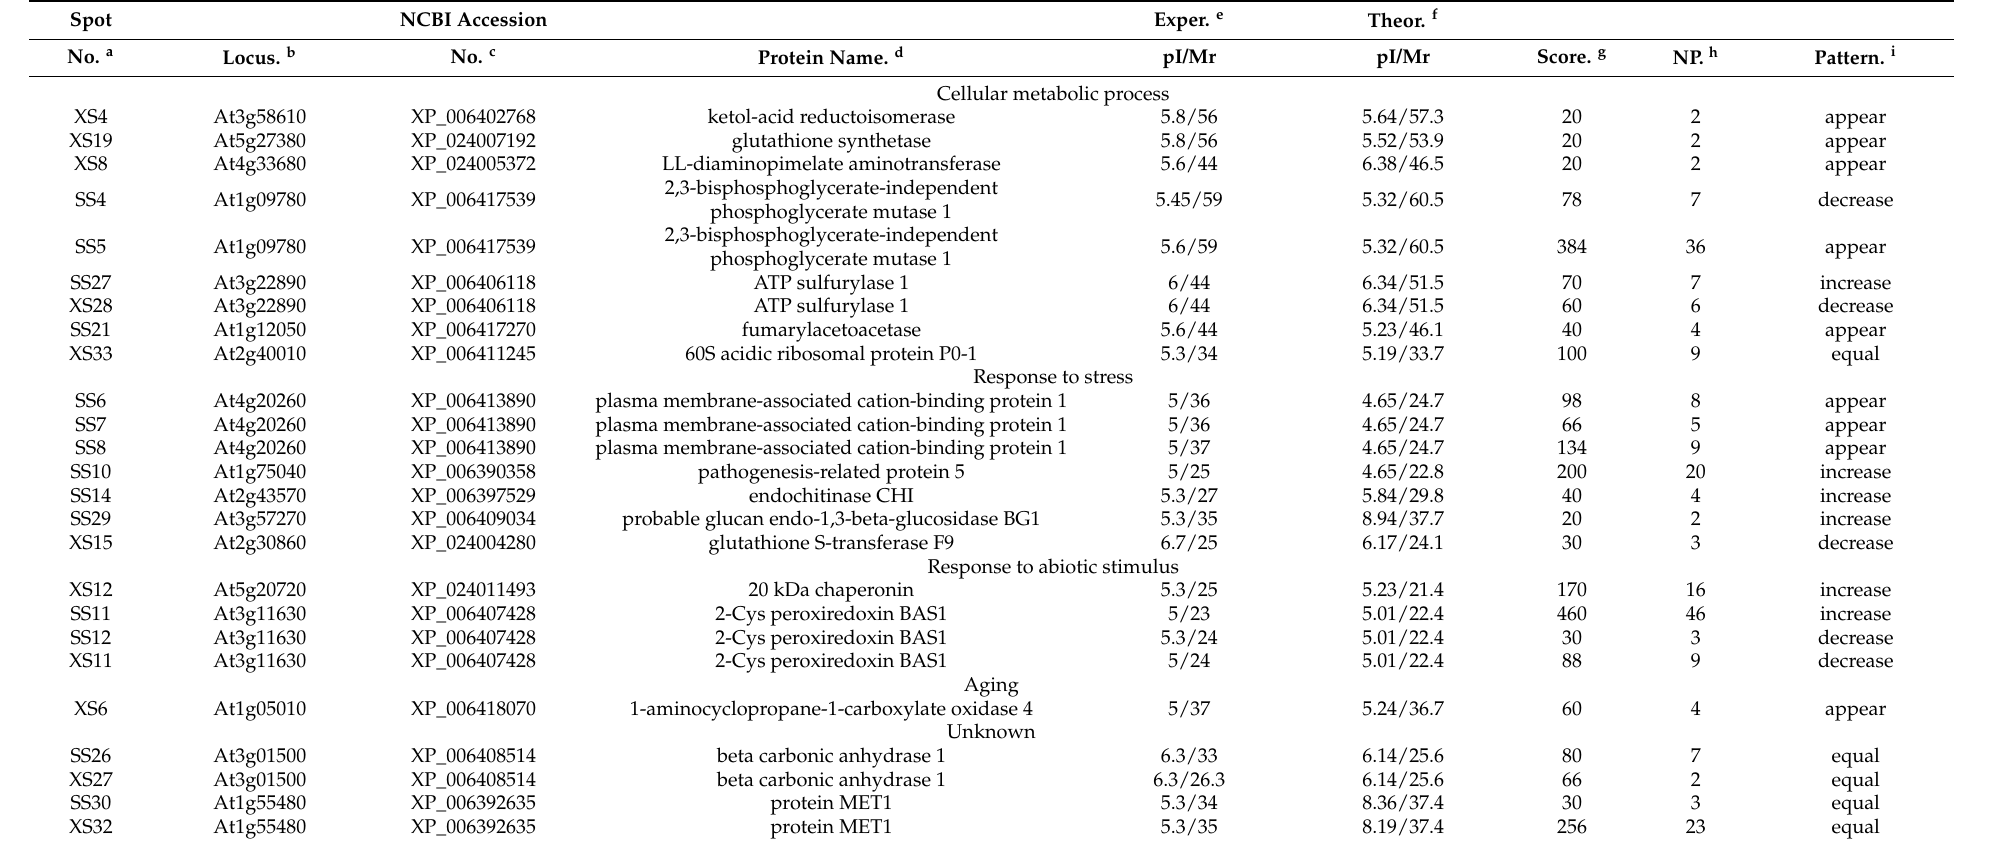
Table 1. Differentially expressed proteins identified in shoots of SD and XJ ecotype of Eutrema